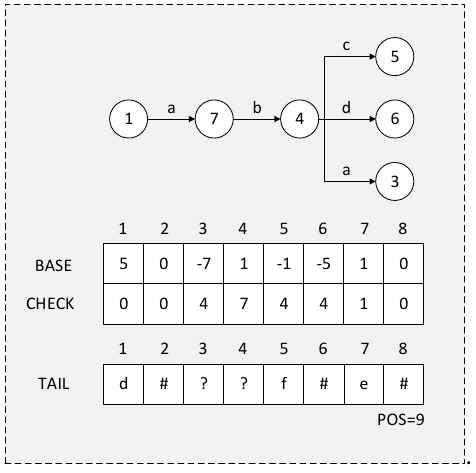
Figure 1. Reduced trie and DA for S.